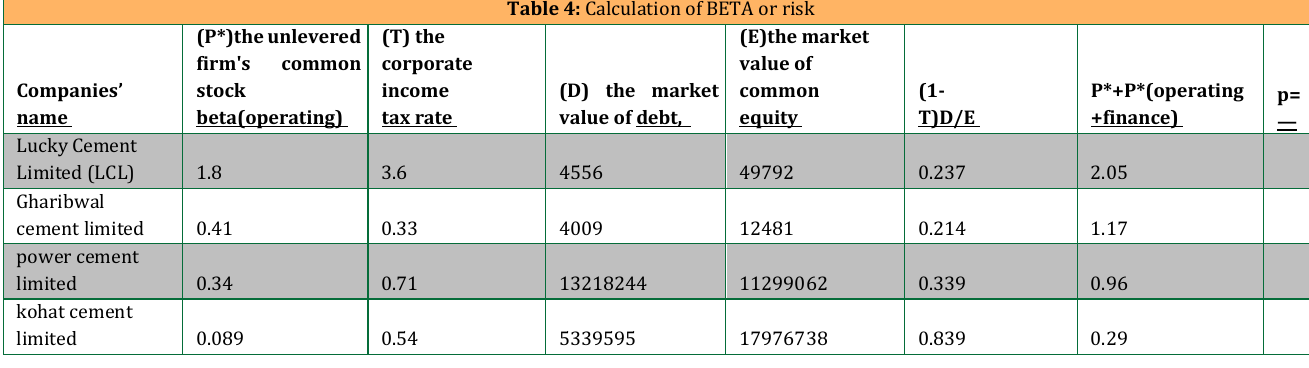
Table 4: Calculation of BETA or risk